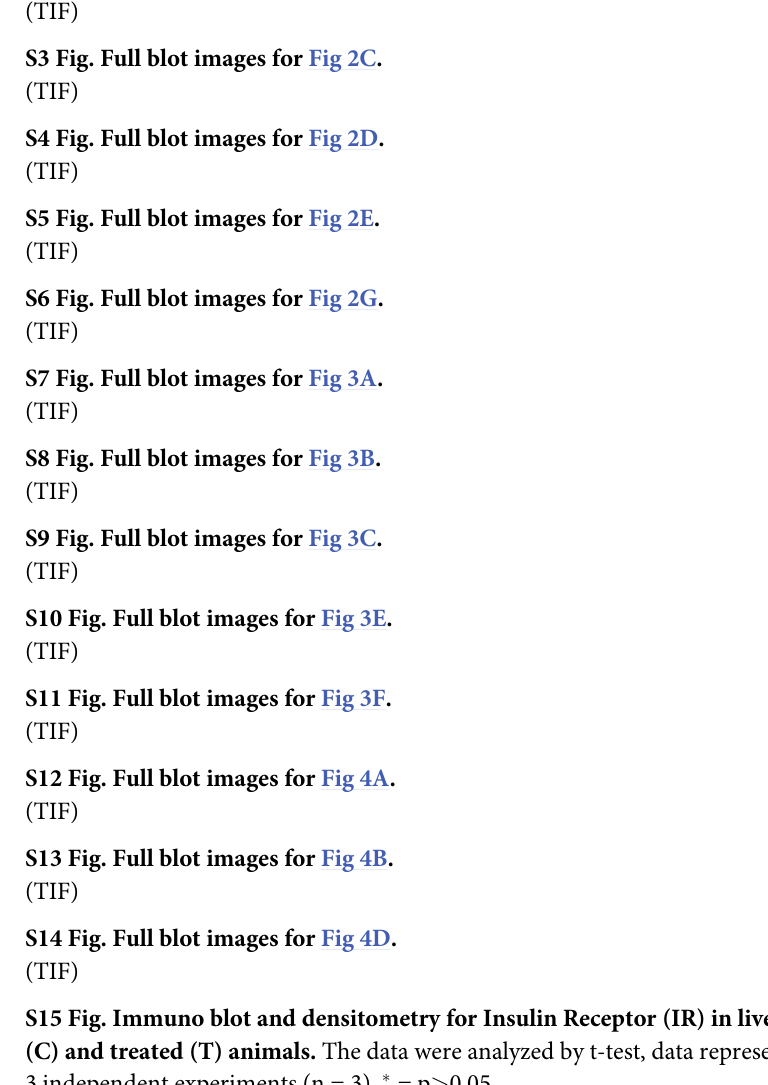
S1 Fig. Full blot images for Fig 2A. S2 Fig. Full blot images for Fig 2B. S3 Fig. Full blot images for Fig 2C. S4 Fig. Full blot images for Fig 2D. S5 Fig. Full blot images for Fig 2E. S6 Fig. Full blot images for Fig 2G. S7 Fig. Full blot images for Fig 3A. S8 Fig. Full blot images for Fig 3B. S9 Fig. Full blot images for Fig 3C. S10 Fig. Full blot images for Fig 3E. S11 Fig. Full blot images for Fig 3F. S12 Fig. Full blot images for Fig 4A. S13 Fig. Full blot images for Fig 4B. S14 Fig. Full blot images for Fig 4D. S15 Fig. Immuno blot and densitometry for Insulin Receptor (IR) in liver of control (C) and treated (T) animals. The data were analyzed by t-test, data represents mean ± S.D. of 3 independent experiments (n = 3), � = p >